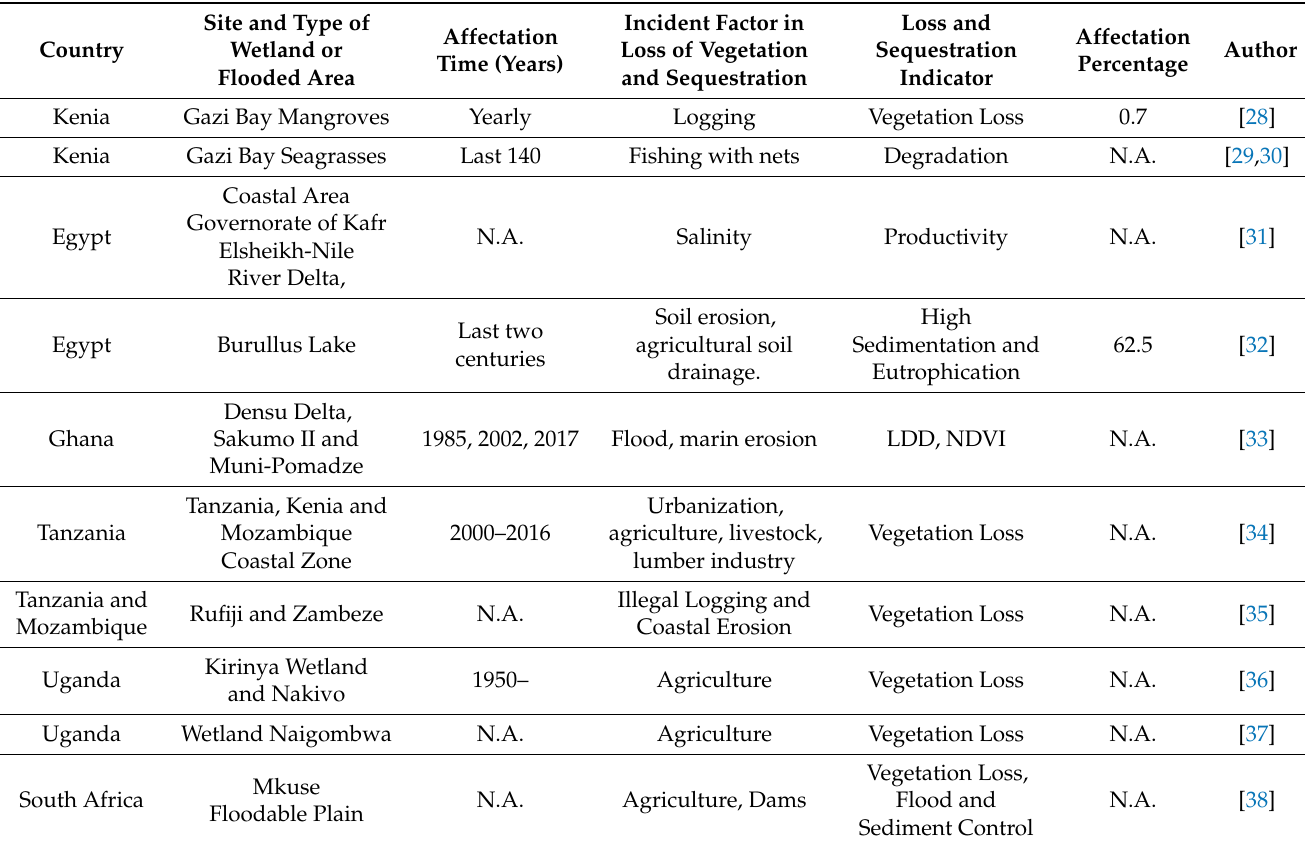
Table 1. Data from the African continent on wetlands in coastal, marine, and continental zones (n =